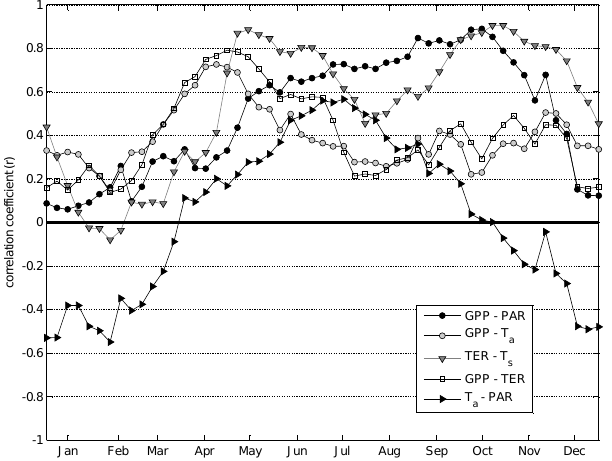
Fig. 1. Temporal variation of the correlation coefficient ( r ) between GPP and TER and their expected drivers: air temperature ( T a ) soil temperature ( T s ), (B-horizon, 10–25cm depth) and photosyntheti- cally active radiation (PAR). r is calculated from daily mean values within a 30-day moving window (29 day overlap) using data from years 1997–2005 and 2007. Values of r are shown at 7 day intervals.